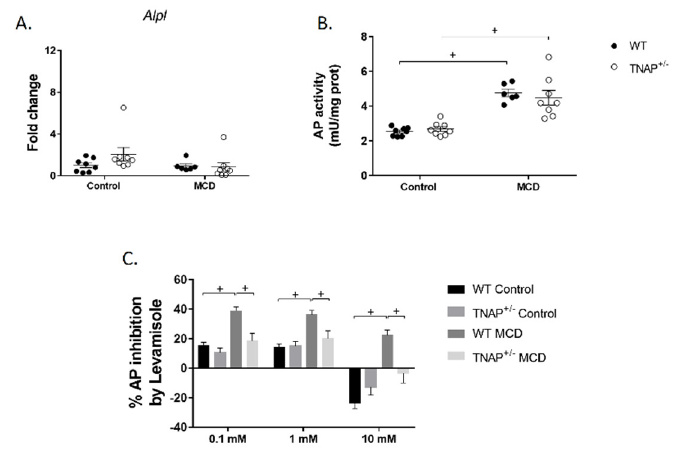
Figure 3. Hepatic alkaline phosphatase expression ( A ), activity ( B ) and sensitivity to levamisole ( C ) of wild-type (WT) and TNAP heterozygous mice (TNAP +/ − ) fed a control diet (10% w/w fat, control) or the same diet deficient in choline and methionine (MCD). For AP expression, fold change qRT-PCR data are shown. + p < 0.05.